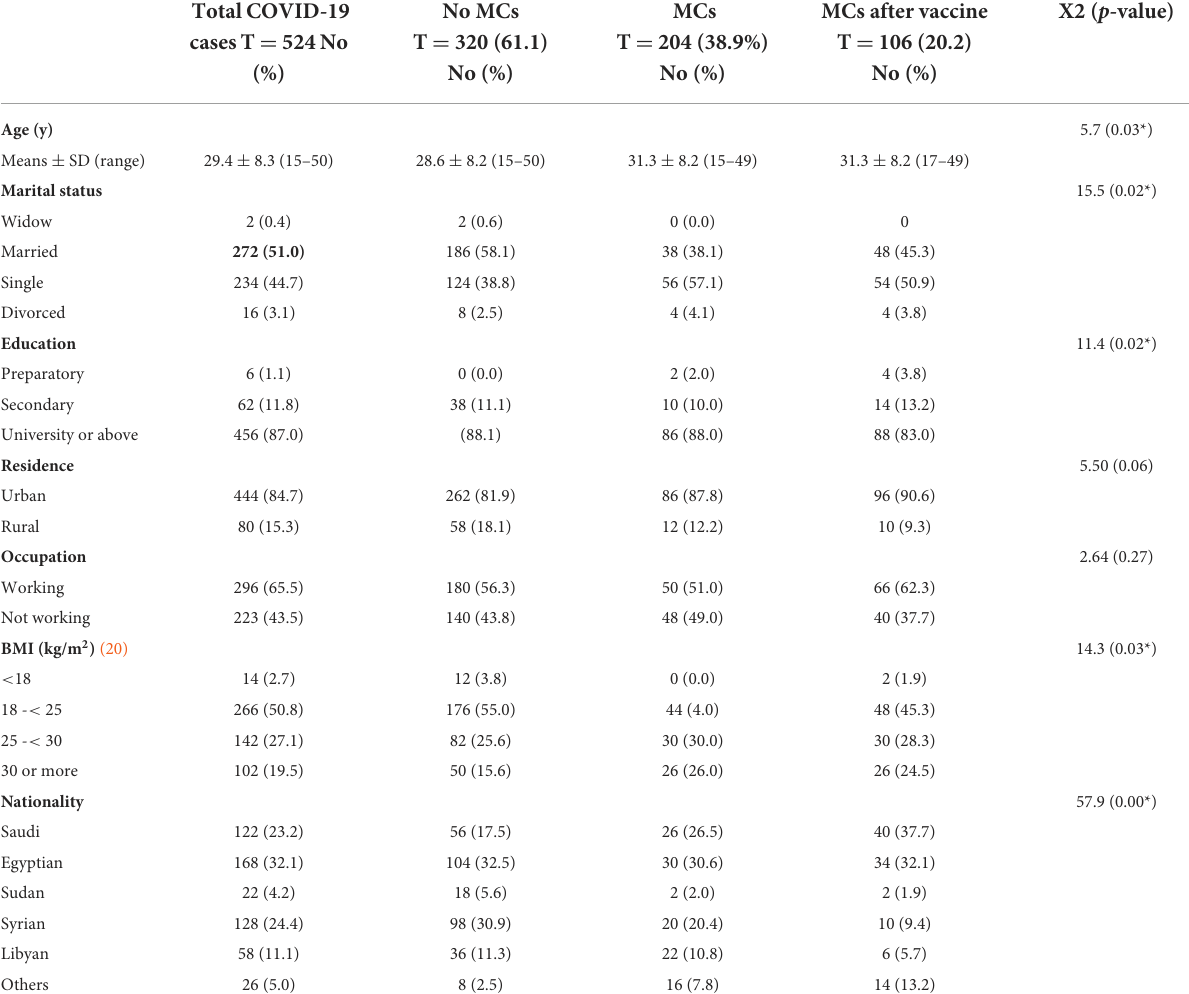
TABLE 5 Demographic data and its relationship with the MCs among COVID-19